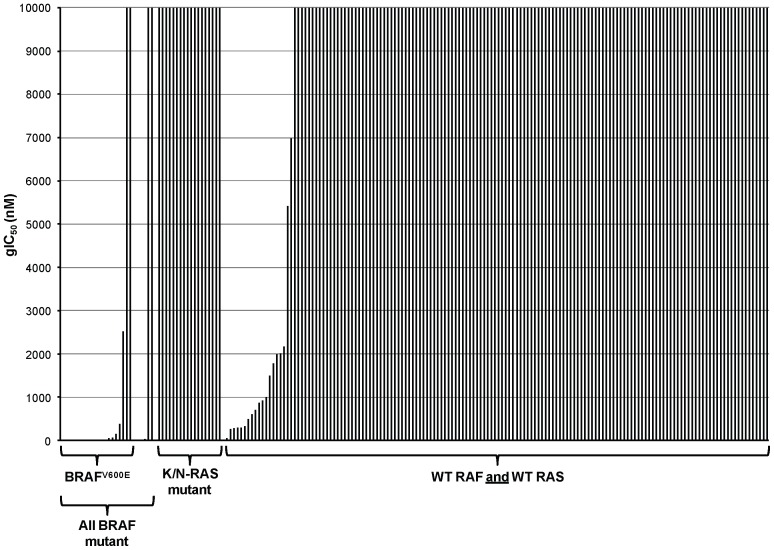
Dabrafenib shows functional selectivity for BRAFV600D/E/K tumor cell growth inhibition.The functional selectivity of dabrafenib was evaluated by measuring the growth of a range of human tumor cell lines of different genetic mutation status. Cells were treated with a concentration range of dabrafenib in a 3-day proliferation assay and growth IC50 (gIC50) values were measured.